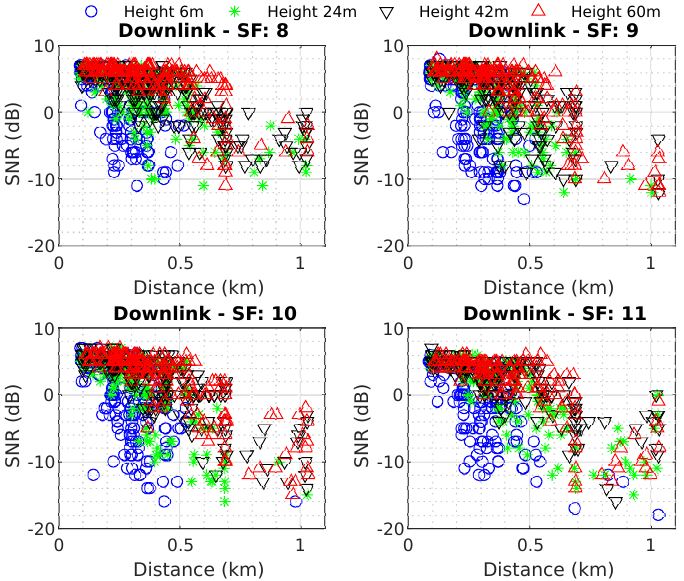
Figure 8. Downlink measured data SNR vs.